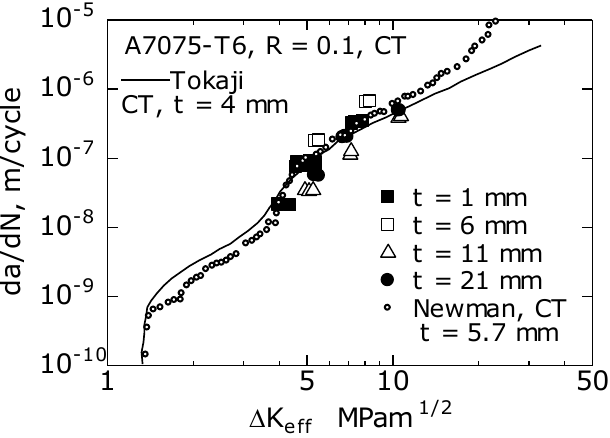
Figure 5. Relationship between da/dN and effective stress intensity factor range ∆ K eff . When the da/dN– ∆ K and da/dN– ∆ K eff relationships are plotted on a log–log graph, an inverted S-shape is shown [23]. In steel materials, excluding the vicinity of the threshold of the FCG ( ∆ K th ) and unstable crack growth regions, the da/dN– ∆ K relationship in the intermediate FCG region is shown as a straight line; hence, the Paris law ap-